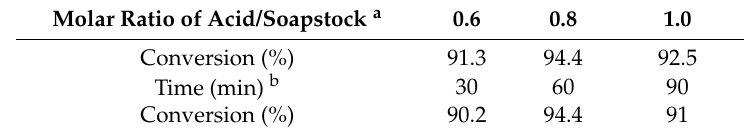
Table 2. Effect of the acid/soapstock molar ratio a and effect of the time on soapstock acidulation b . Molar Ratio of Acid/Soapstock